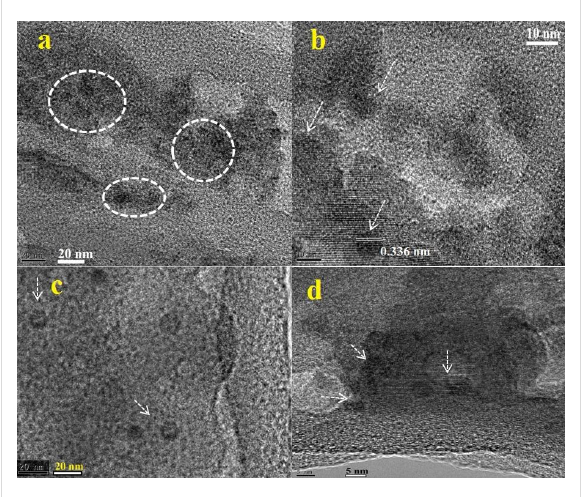
Figure 9: High-resolution transmission electron microscopy images of the GCN-5 quantum